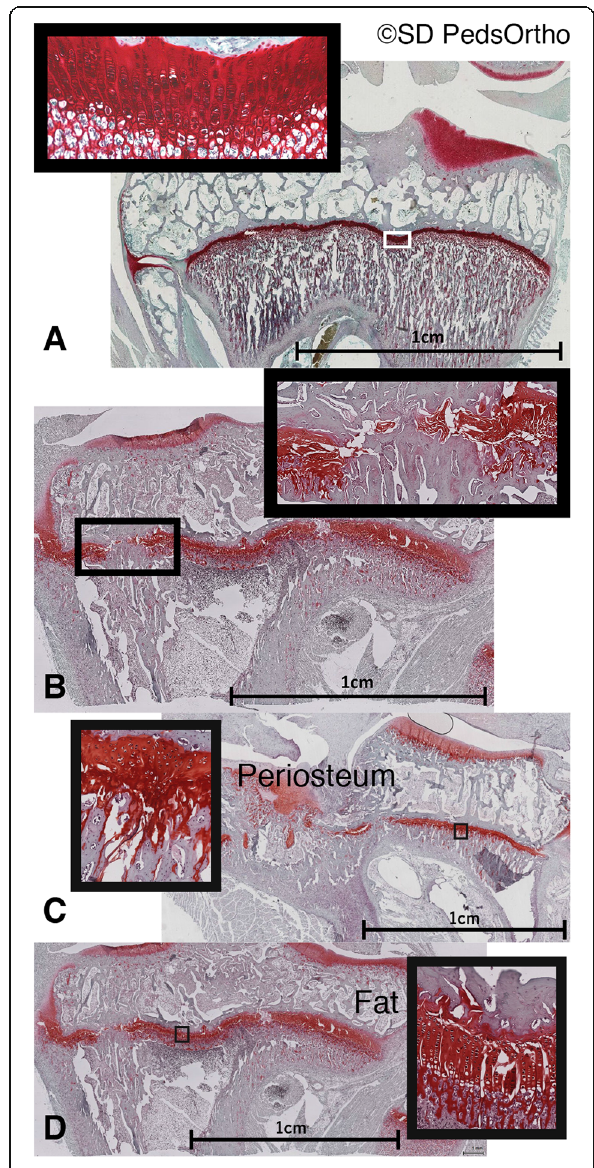
Fig. 5 Representative mid-coronal sections (SafraninO stain). Cartilage is dark. a Sham Group: No bony bridges. b Fat Group: Bony bridge seen. c Representative physes from periosteum and d fat groups, showing disruption of chondrocyte organization compared to sham in Fig.